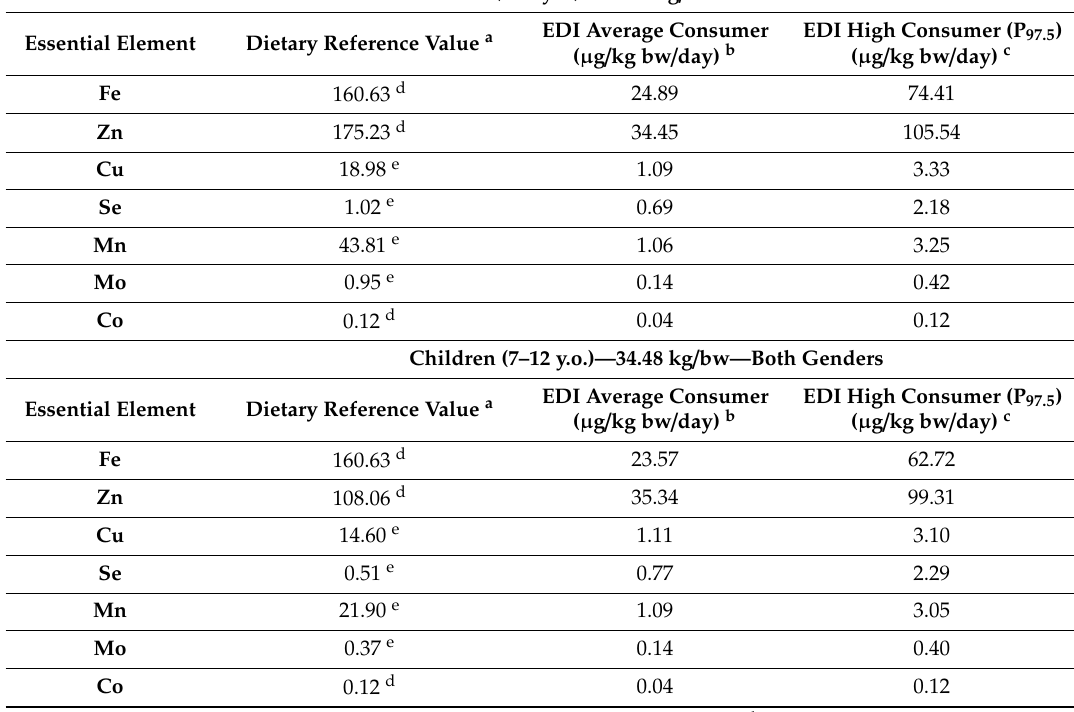
Table 4. Estimated daily intake of essential elements through the consumption of mussels by adults and